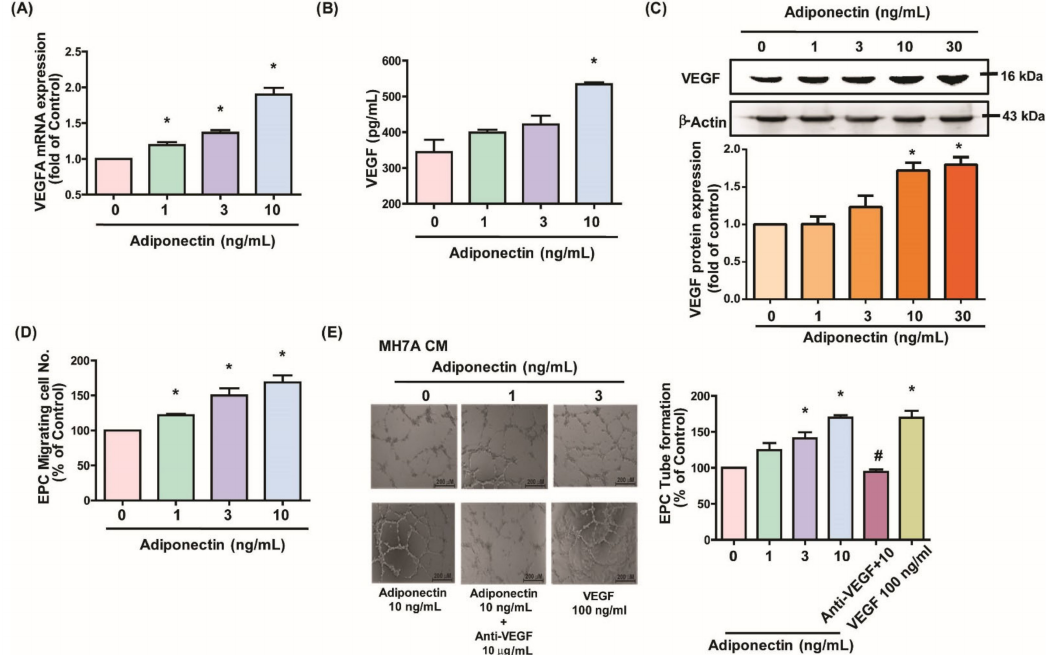
Figure 1. Adiponectin stimulates VEGF expression in MH7A cells and promotes EPC angiogenesis. ( A – C ) MH7A cells were treated with prespecified concentrations of adiponectin (0–10 ng/mL) for 24 h. VEGF expression was examined by qPCR, ELISA, and Western blotting ( n = 4 per group). ( D , E ) MH7A cells were treated with adiponectin (0–10 ng/mL) or pretreated with 30 min with VEGF antibody for 30 min then stimulated with adiponectin (10 ng/mL) for 24 h. Medium was collected as CM; 200 µ L of 20% FBS MV2 medium and 150 µ L of MH7A CM was applied to the EPCs. Capillary-like structure formation and in vitro cell migration in EPCs were examined by the Transwell and tube formation assays. Direct application of VEGF (100 ng/mL) served as the positive control in EPC tube formation and migration ( n = 5 per group). * p < 0.05 versus the control group; # p < 0.05 versus the adiponectin-treated group.